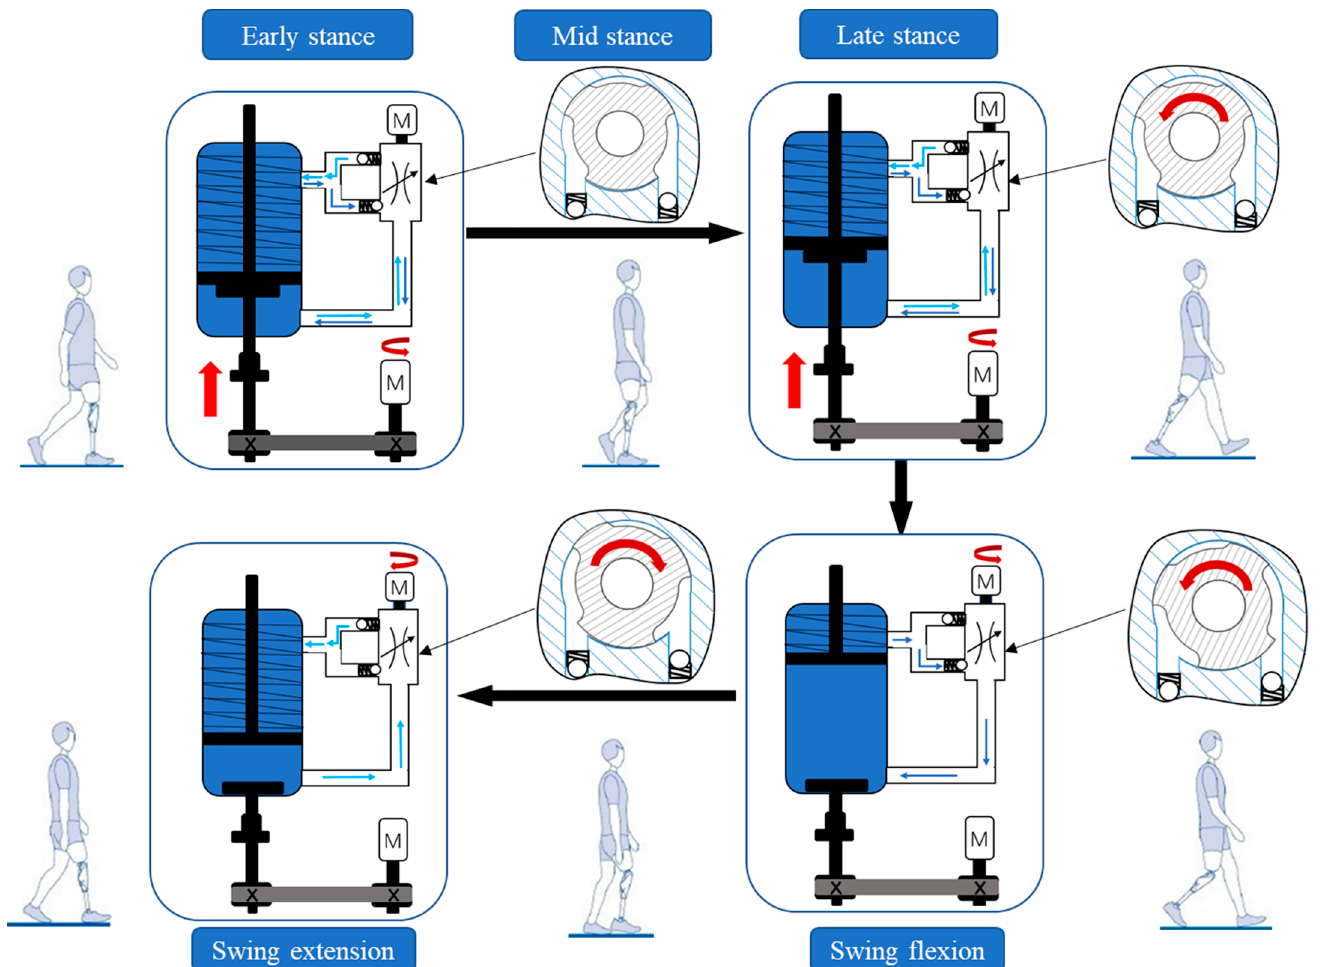
Figure 5. The work scheme of the semi-active prosthetic